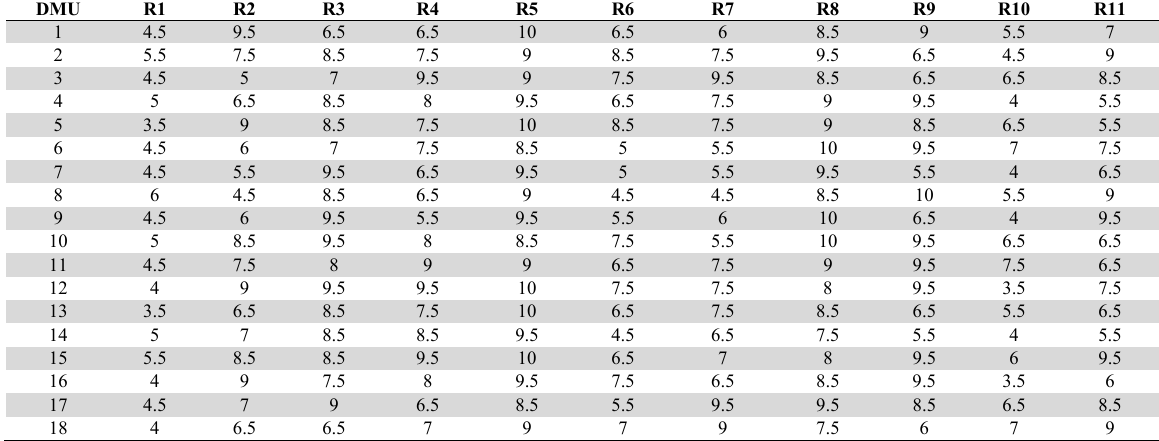
The average values of retailers’ each trust factor (average of two items for each factor in the questionnaire)